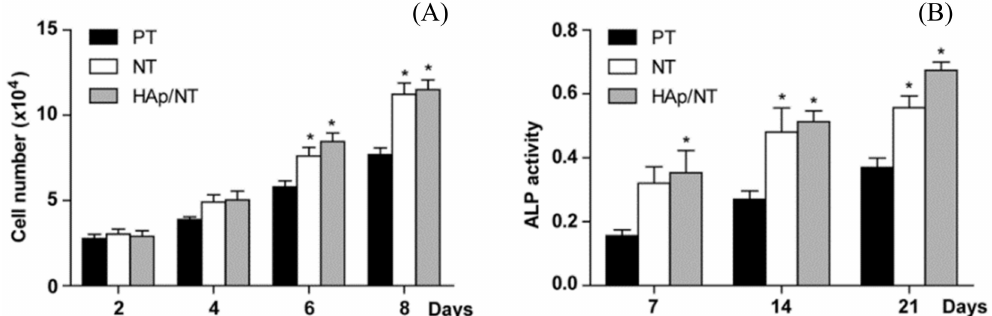
Figure 5. ( A ) Cell vitality and ( B ) Alkaline phosphatase (ALP) activity of MC3T3-E1 cells after 2, 4, 6 and 8 days of exposure to PT, NT and HAp / NT (Reproduced with permission from Liu et al., Rapamycin / sodium hyaluronate binding on nano-hydroxyapatite coated titanium surface improves MC3T3-E1 osteogenesis; published by PLOS ONE, 2017, CC BY 4.0